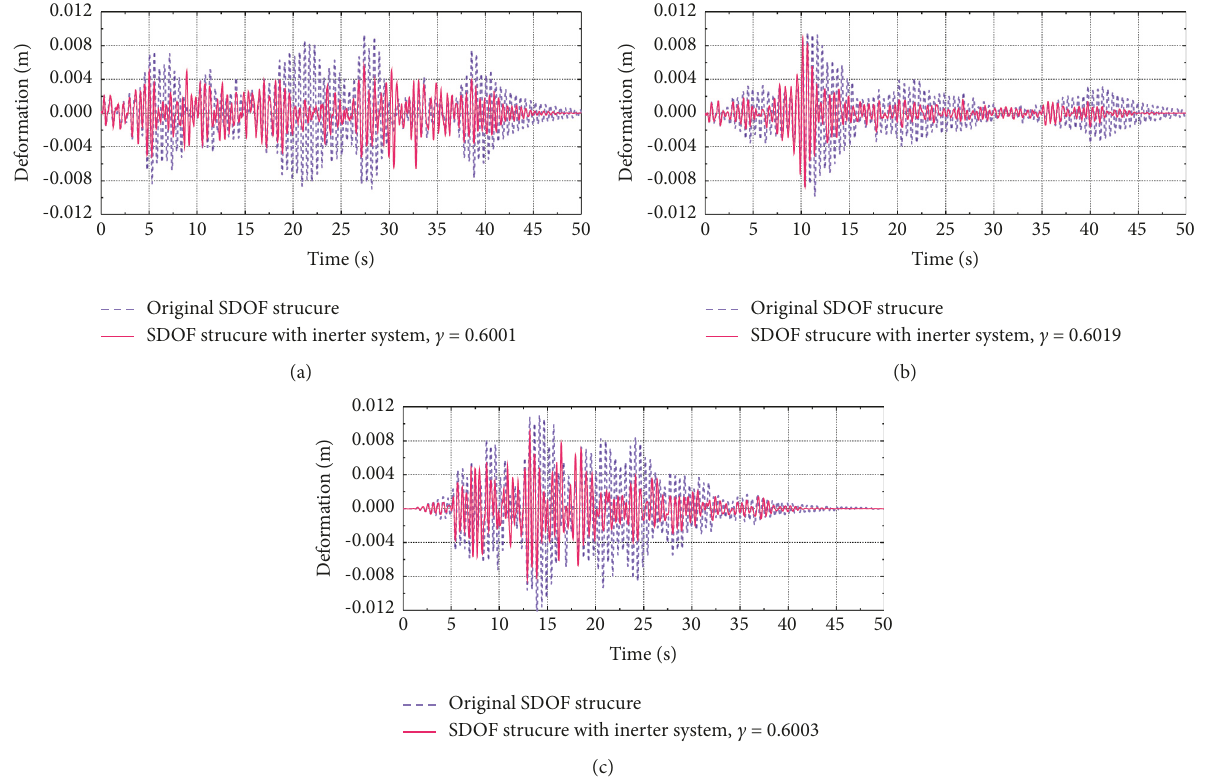
Figure 15: Displacement response curves of structures with inerter systems under different seismic excitations. (a) White noise excitation. (b) Artificial seismic excitation. (c) Natural seismic